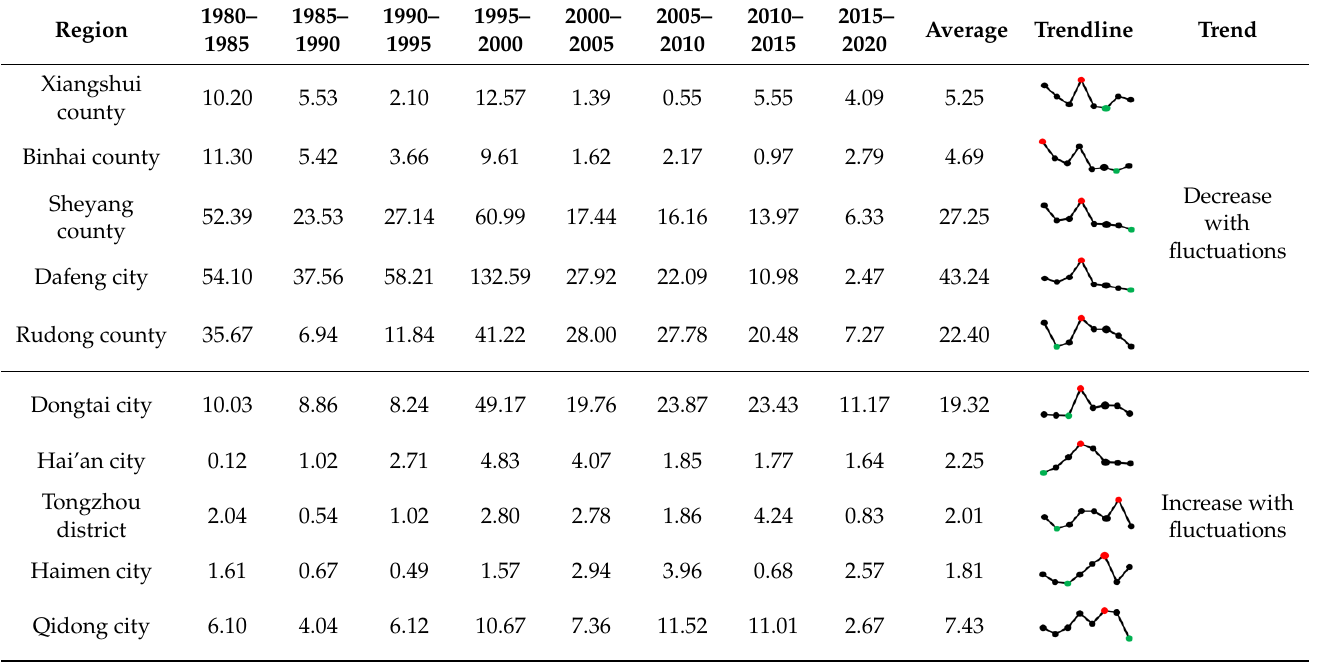
Table 5. Changes of the coastal wetland areas’ rates of restoration in 10 counties and cities in the study area over eight periods. 1980– Region